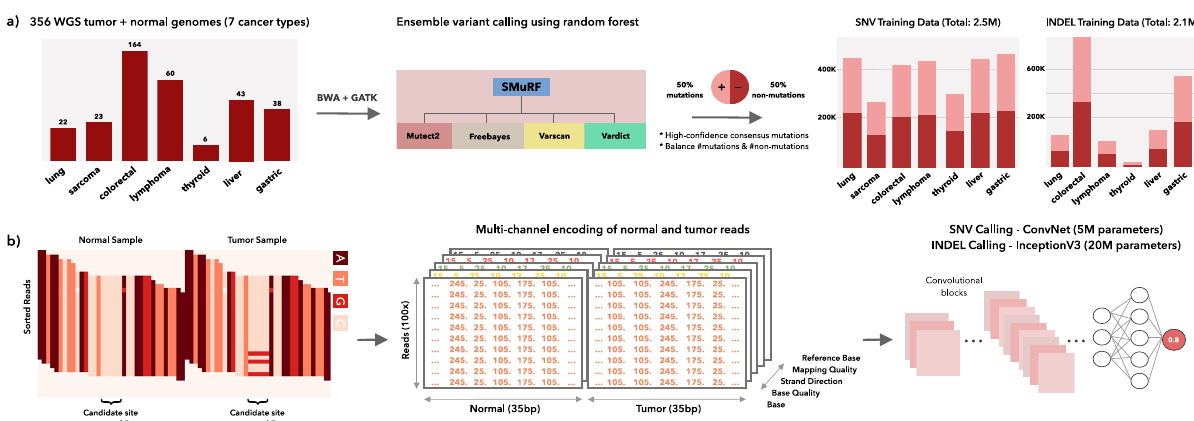
Fig. 1 Overview of approach. a Matched tumor/normal genomes were used to generate training data. Training labels were generated using high- con fi dence calls from 4 variant callers (via SMuRF). b Each genomic position selected for training is encoded as a multi-dimensional matrix of reads and associated features (e.g. base quality and mapping quality) and fed to a CNN for training. Source data are provided as a Source Data fi le.